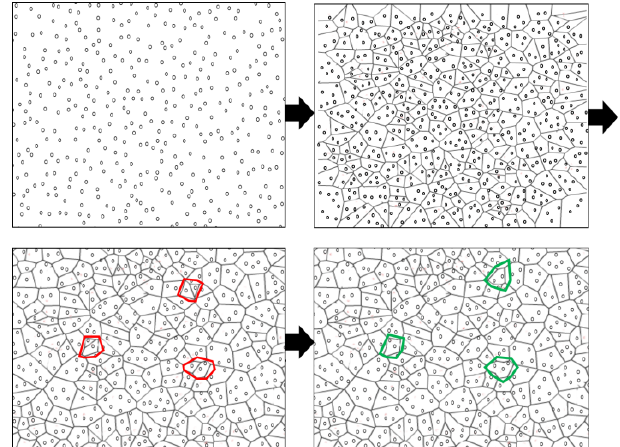
Figure 2. Voronoi diagram creation after node deployment. Upper left part of the figure shows initial random node deployment. Upper right part is the figure with Voronoi cell creation. Cells marked in red color on the bottom left shows an example of cells with very close nodes. These marked cells are merged into one cell. The bottom right section shows the Voronoi cells after merging. After that, only one active node per cell is selected and the rest of the nodes are put in sleep mode.